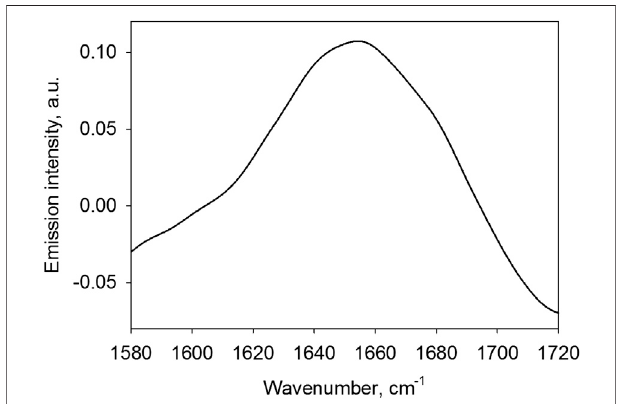
FIGURE 9 | Emission spectrum of a 0.5 mg/ml IFN γ solution in the region of the Amide I band divided by the population of energy levels (1).